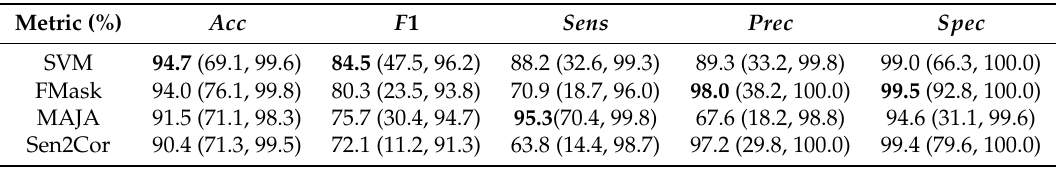
Table 5. The comparison of segmentation performance on the D 3 dataset according to different metrics. In bold, we reported the higher values for each validation